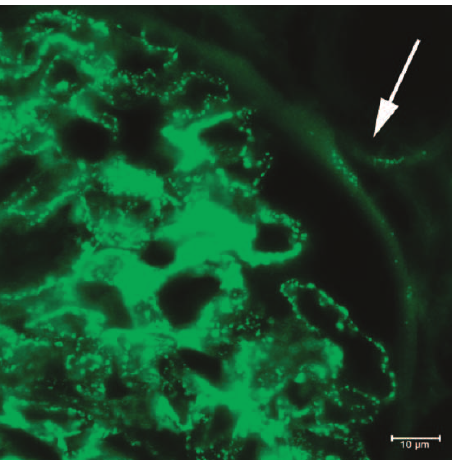
Figure 2. Kidney section of an SPHN untreated rat stains for rat IgG in the glomerular capillary loops with a diffuse beaded pattern of fluorescence by a direct fluorescence antibody test. The Bowman’s capsule and the tubular basement membrane also stain with beaded deposits (white arrow).